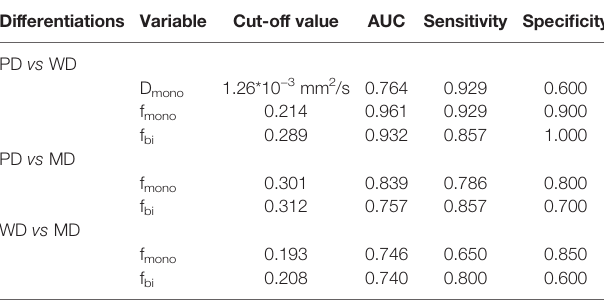
TABLE 2 | The diagnostic ef fi cacy between the two models for the pathological grade of ESCC. Differentiations